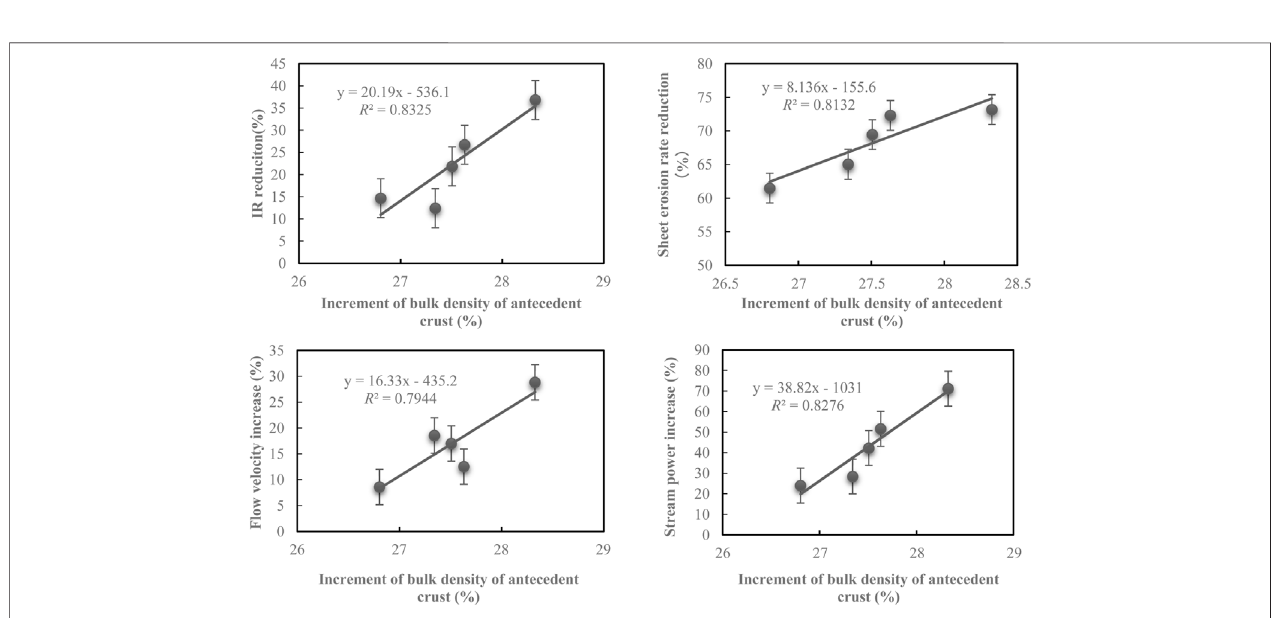
FIGURE 4 | Relationships between percent changes of bulk density of antecedent crust and in fi ltration, erosion rates, fl ow velocity, and stream power.